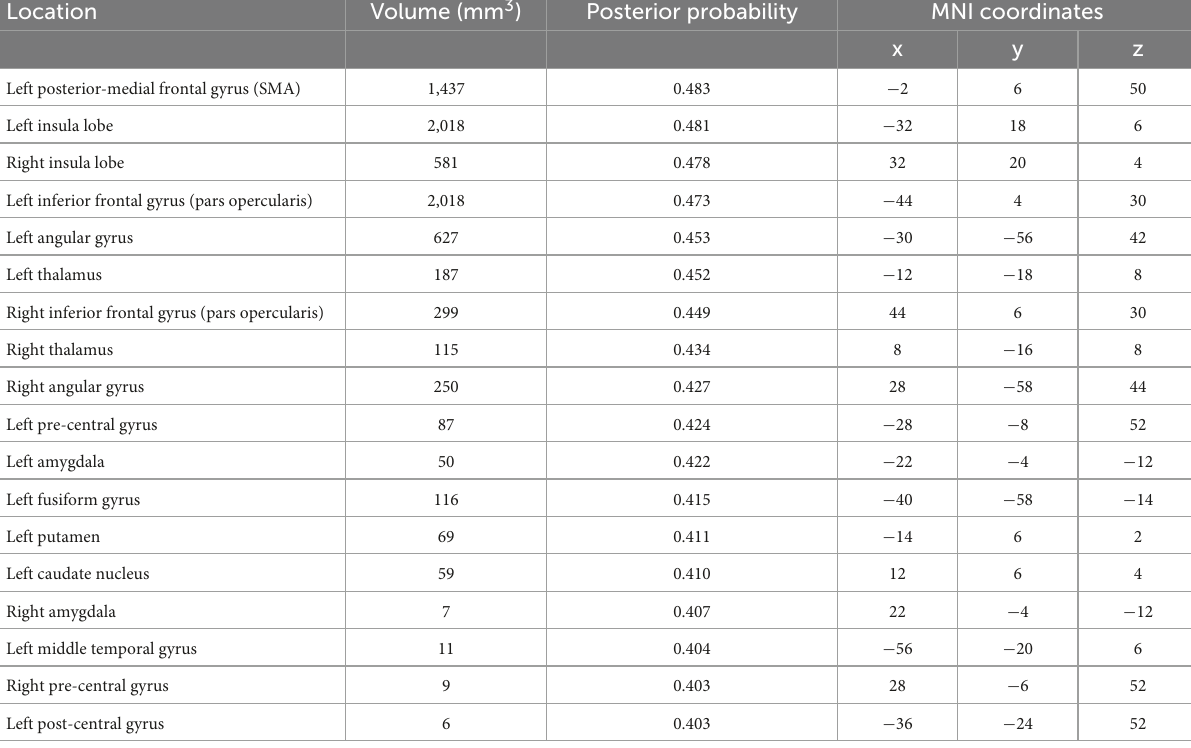
Shows all local maxima separated by more than 20 mm. Regions were automatically labeled using the Anatomy Toolbox atlas. x, y, and z = Montreal Neurological Institute (MNI)